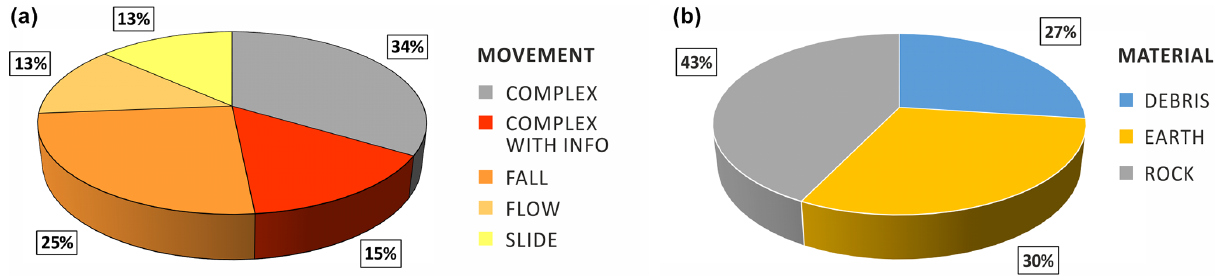
Figure 4. Landslide events classified according to the type of movement (a) and displaced material (b)